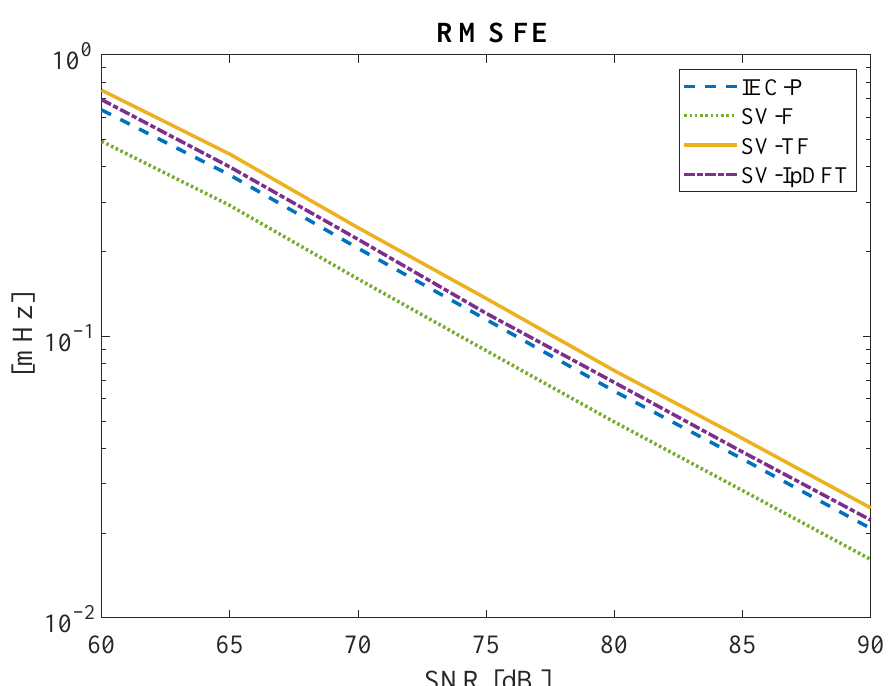
Figure 14. RMS FE in the presence of additive wideband noise at different SNRs.